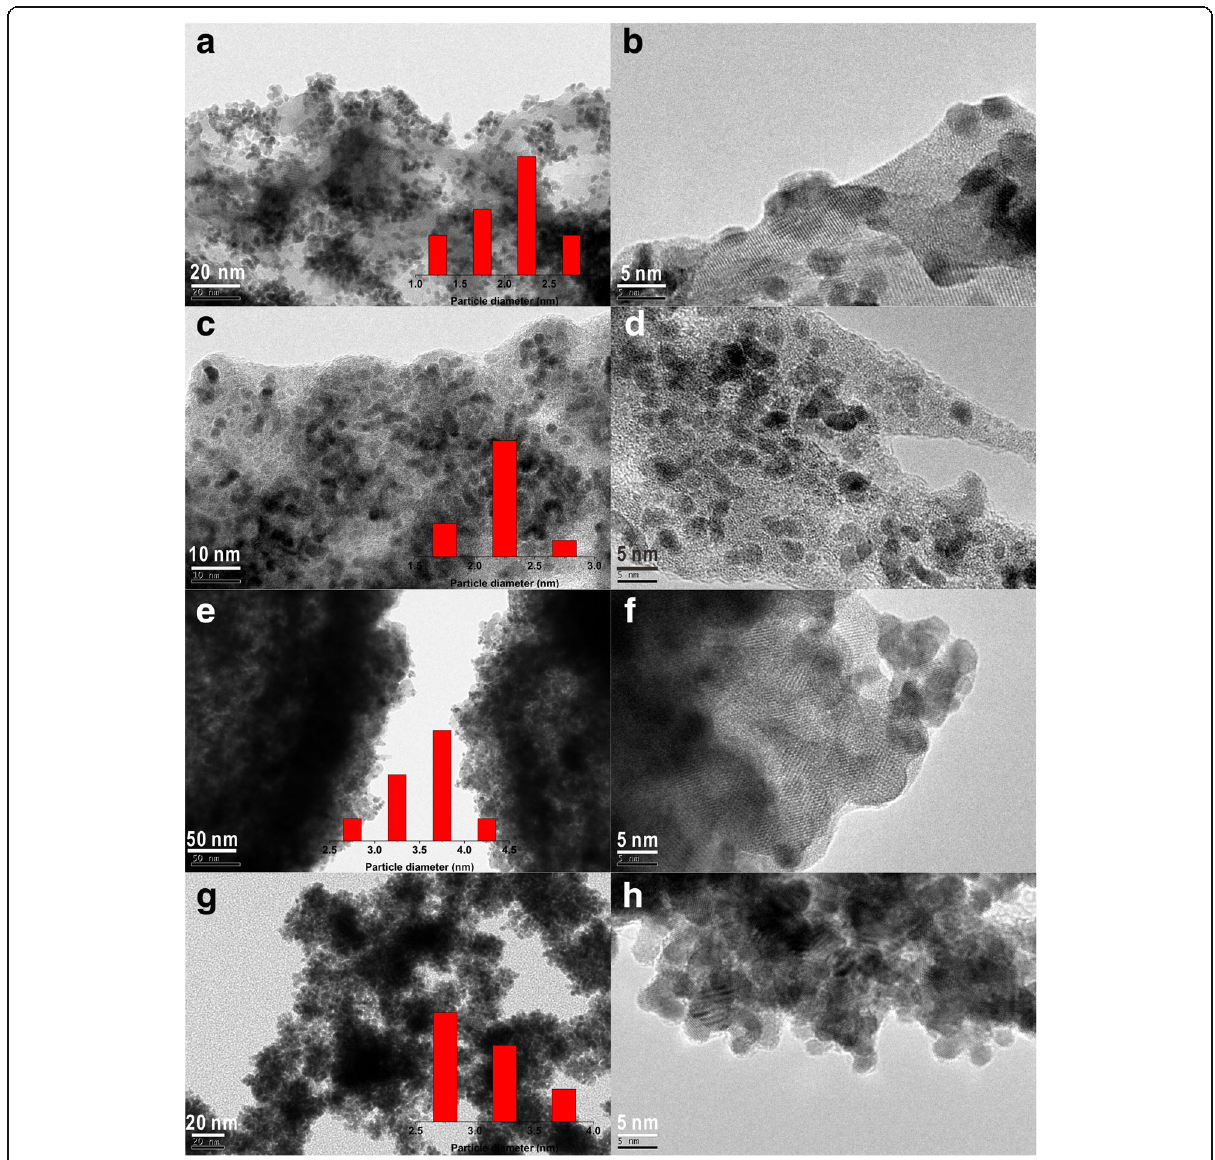
Fig. 3 High-resolution TEM images of Pt nanoparticles supported on La 2 O 3 prepared by the a , b ultrasonication-acoustic levitation method, c , d acoustic levitation method, e , f ultrasonication-colloidal deposition method, and g , h conventional colloidal deposition